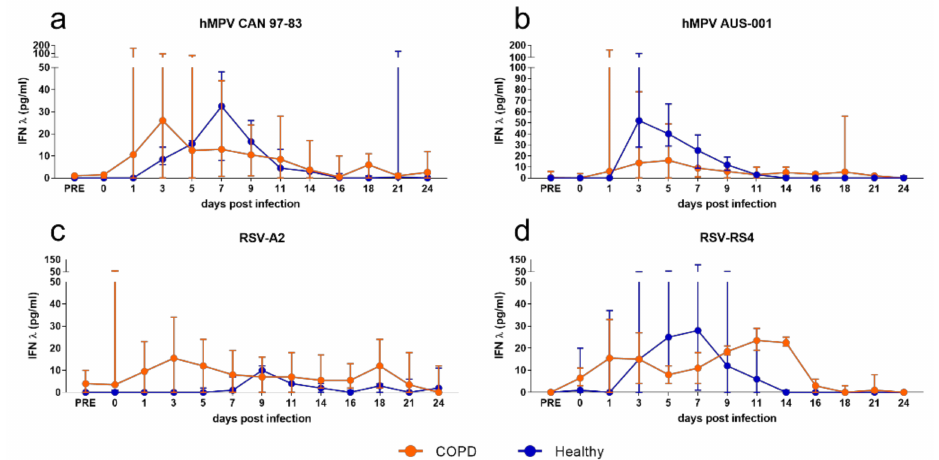
Figure 5. IFN- λ production by well-differentiated BEC cultures infected with ( a ) CAN 97-83 ( b ) AUS- 001 ( c ) A2 or ( d ) RS4, MOI 3. Basal medium was sampled 3 times per week and secreted IFN- λ quantified by ELISA. The symbols represent the mean ± SEM. n = 5 for both COPD and healthy groups. Unpaired t -tests were performed, no statistically significant differences were observed.